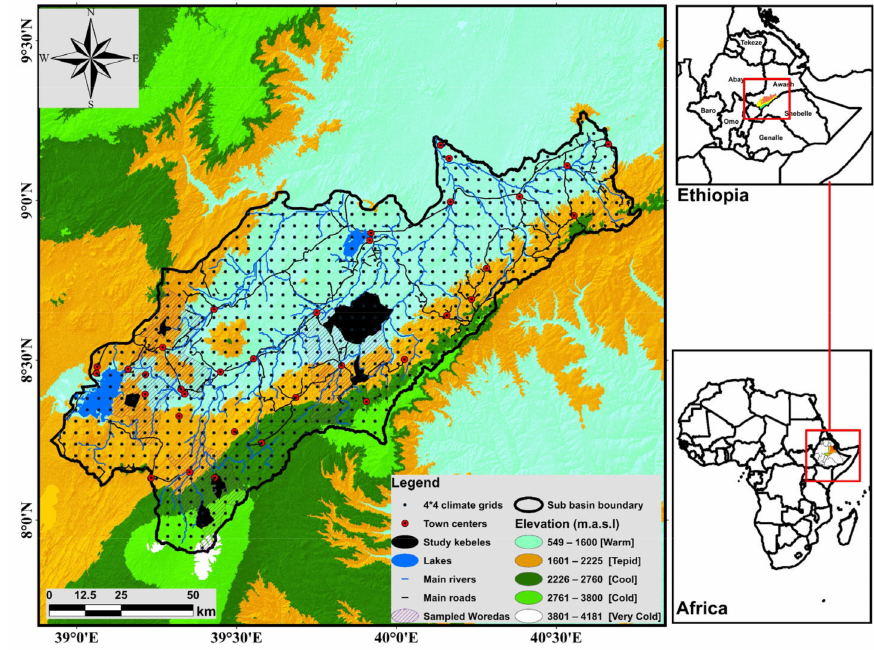
Figure 1. Map of the study